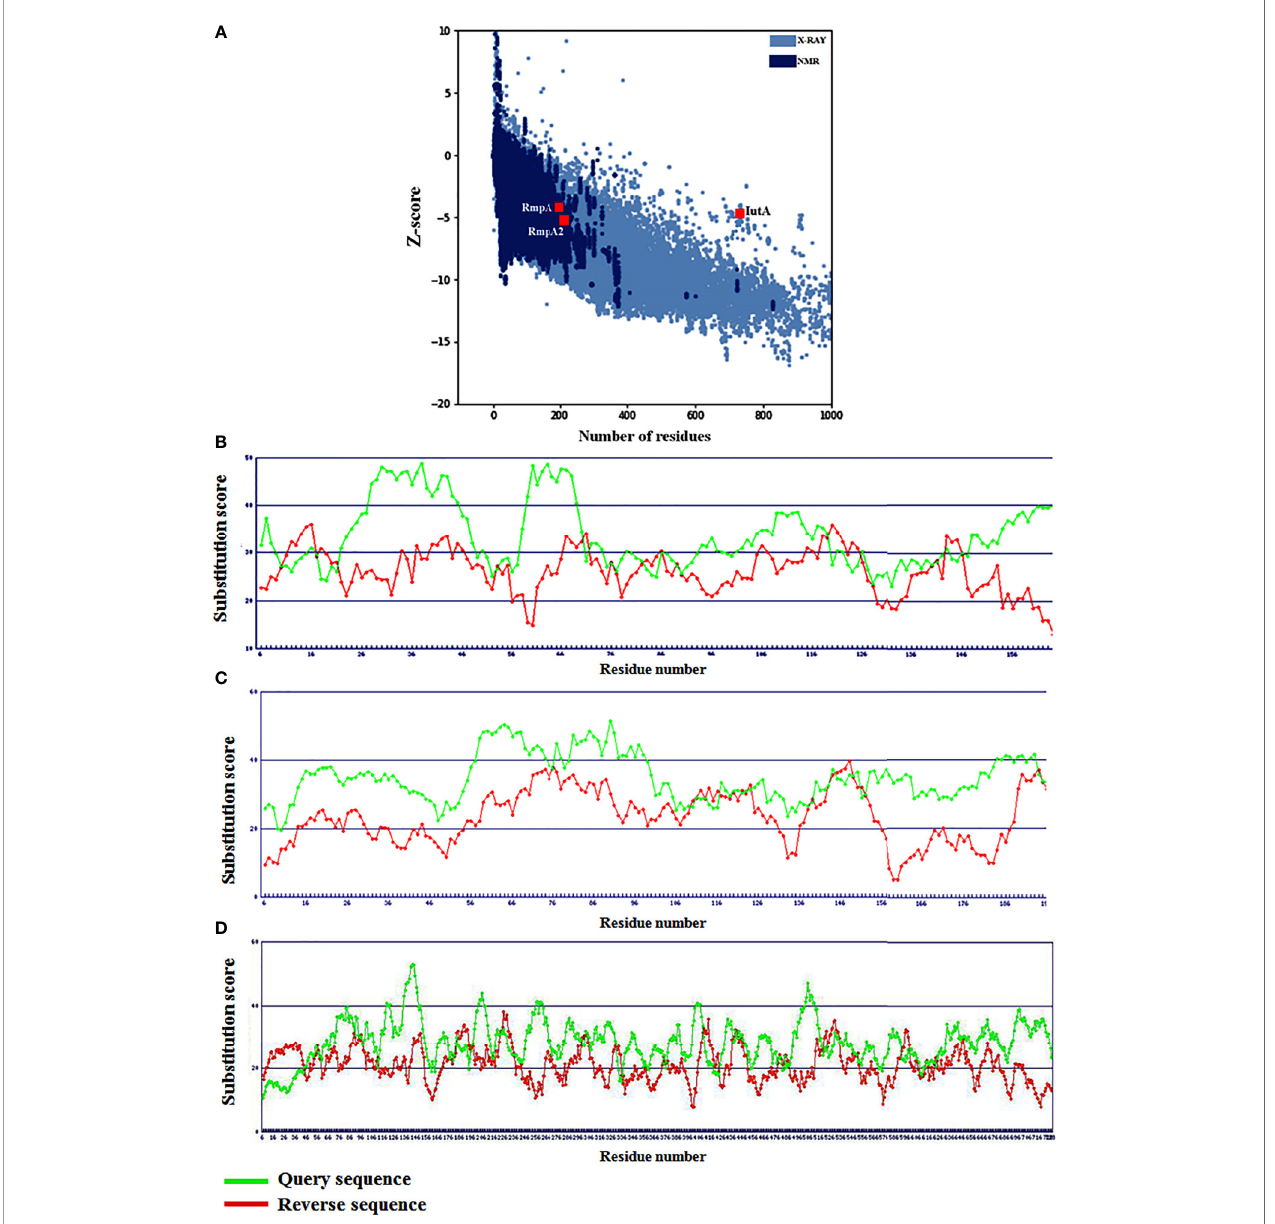
FIGURE 3 | Global model qualities of RmpA, RmpA2 and IutA with respect to (A) experimentally derived structures and (B – D) residue-level substitution scores signifying local folding